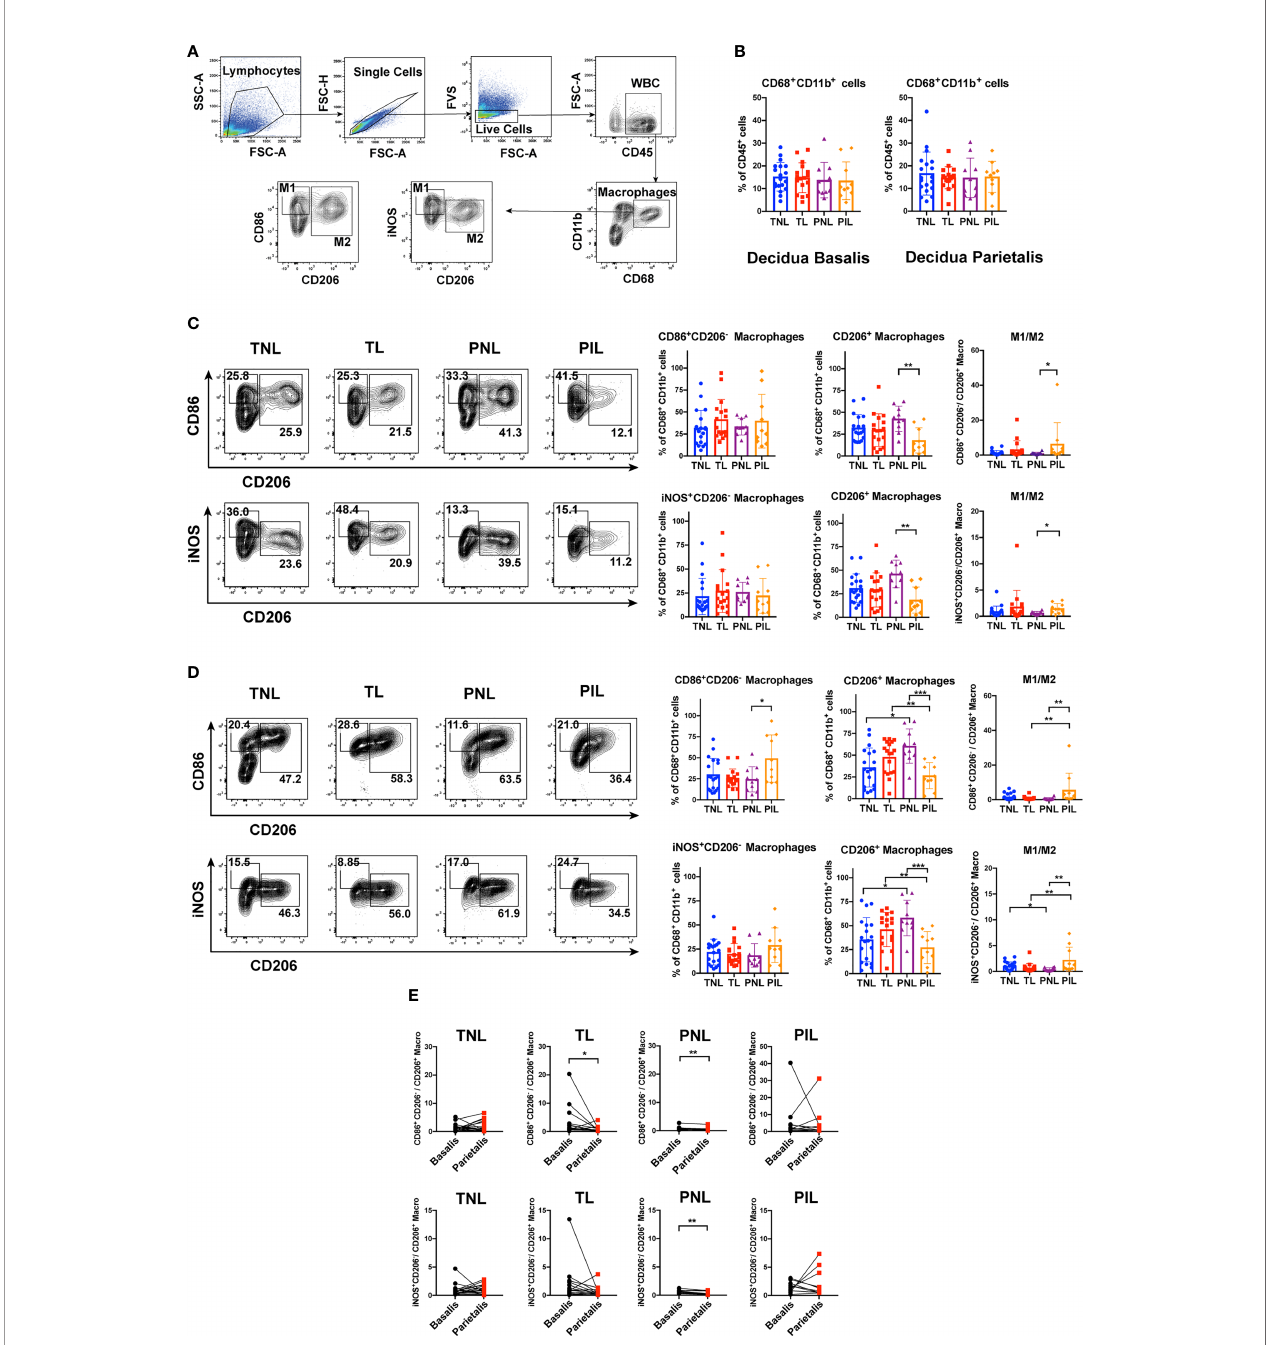
FIGURE 2 | Flow Cytometric Analysis of Macrophages in the Decidua basalis and Parietalis during Term and Preterm Labor. (A) Gating strategy used for determining macrophages (CD45 + CD68 + CD11b + cells), M1 (CD86 + CD206 - cells or iNOS + CD206 - cells) and M2 (CD206 + cells); (B) Comparison of the frequencies of total macrophages in CD45 + cells among the four groups in the decidua basalis and parietalis; (C) Comparison of the frequencies of M1 and M2 macrophages, as well as the M1/M2 ratio among the four groups in the decidua basalis; (D) Comparison of the frequencies of M1 and M2 macrophages, as well as the M1/M2 ratio among the four groups in the decidua parietalis; (E) Comparison of the M1/M2 ratio between the decidua basalis and parietalis among the four groups respectively. Continuous variables were presented as mean ± standard deviation. Mann-Whitney U test was used for comparison between two groups, Wilcoxon matched-pairs signed rank test were used for comparison between decidua basalis and parietalis. Differences are indicated: * P < 0.05, ** P < 0.01 and *** P < 0.001. TNL group, N = 19; TL group, N = 17; PNL group, N = 10; PIL group, N =